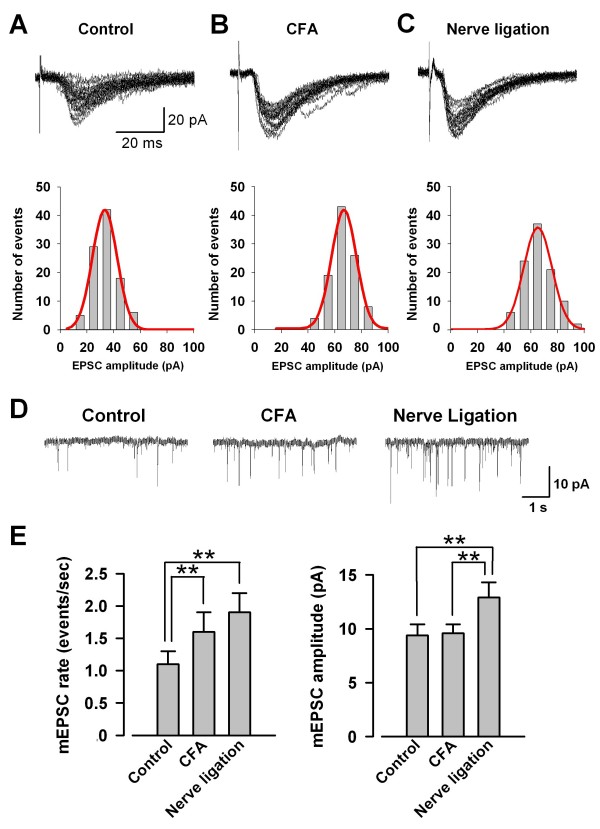
uEPSCs and mEPSCs in ACC synapses after peripheral inflammation and nerve ligation. A-C, Traces indicate 20 consecutive uEPSCs recorded at the stimulus intensity of 5 V in ACC neurons from control mouse (A), mouse following CFA injection (B), and mouse with nerve ligation (C), respectively. Representative histogram of peak amplitude of uEPSCs (100 trials) in ACC neurons from control mouse (A), mouse following CFA injection (B), and mouse with nerve ligation (C), respectively, with a Gaussian curve (Bottom). D, Representative mEPSCs recorded in pyramidal neurons at a holding potential of -70 mV from control mice, mice following CFA injection, and mice with nerve ligation. E, The mean rate (left) and amplitude (right) of mEPSCs in neurons from control mice (n = 12), mice following CFA injection (n = 8), and mice with nerve ligation (n = 9). **p < 0.01.